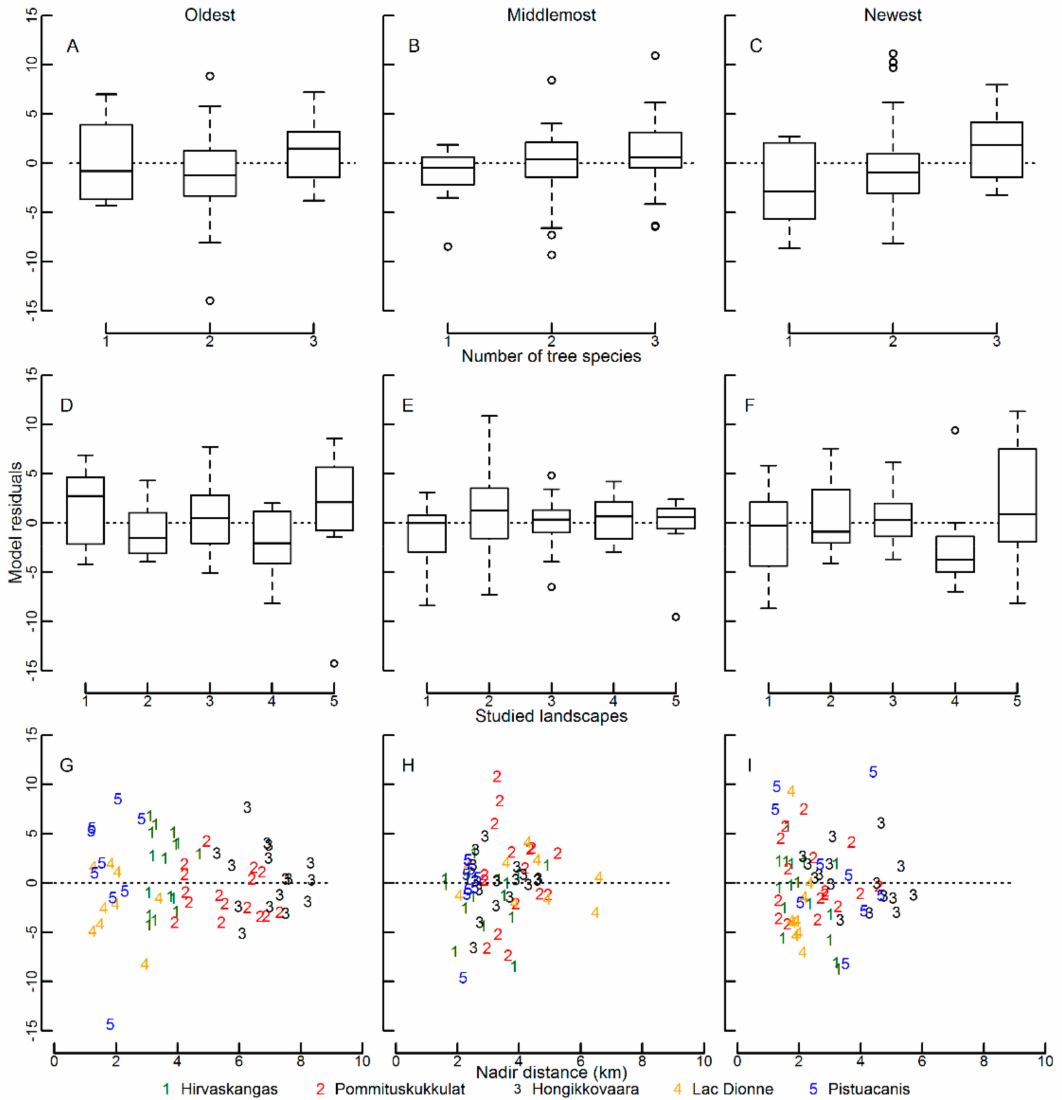
Figure 3. Calibration model residuals in relation to the number of tree species in the field-sampled cells ( A – C ), and the residuals from the model with least residual bias (the model where we explained the calibration model residuals with the number of tree species) in the studied landscapes ( D – F ) and in relation to the nadir distance ( G – I ) for the oldest (first column), middlemost (second column) and the newest (third column) aerial